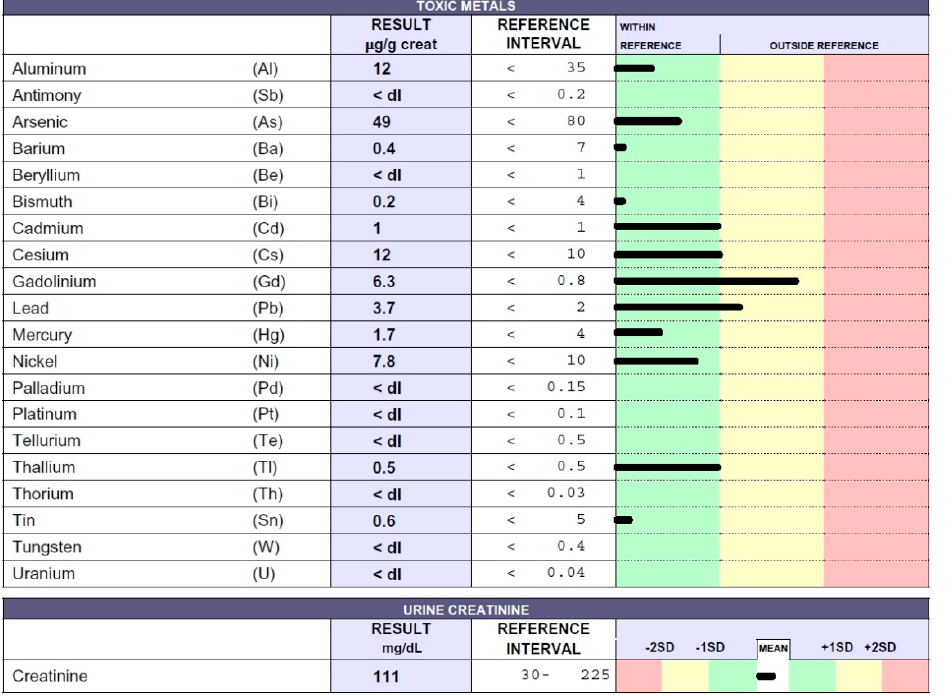
Figure 6. Toxic metal levels measured by ICP-MS method in the patient’s urine collected during the 12 h following EDTA chelation test reported in micrograms (µg) per g creatinine. The patient underwent chelation therapies with EDTA for three years and was affected by MS.